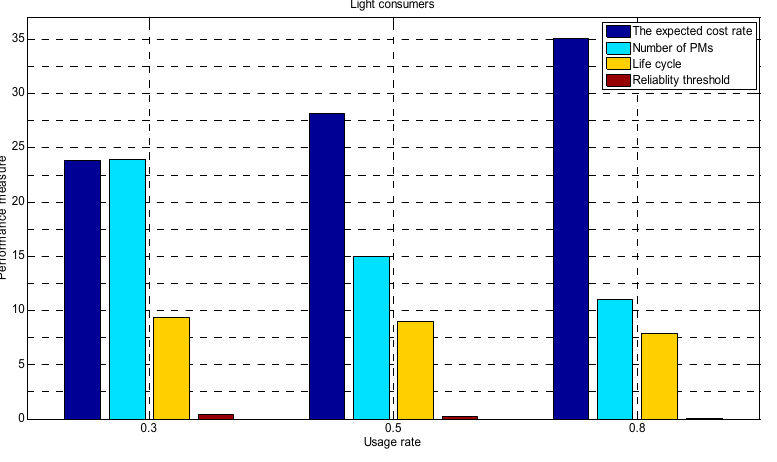
Figure 7. Performance measure versus usage rate.